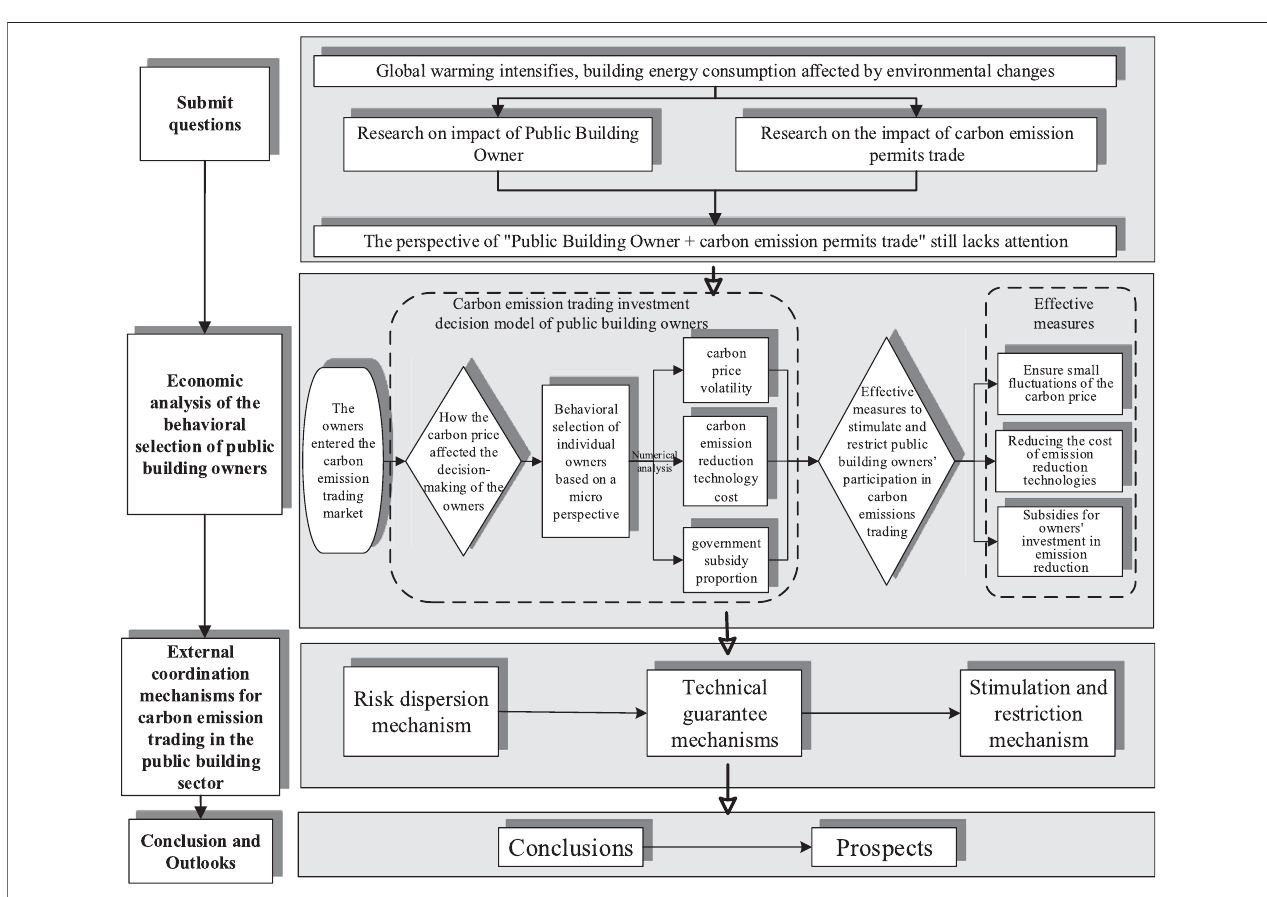
FIGURE 1 | Research